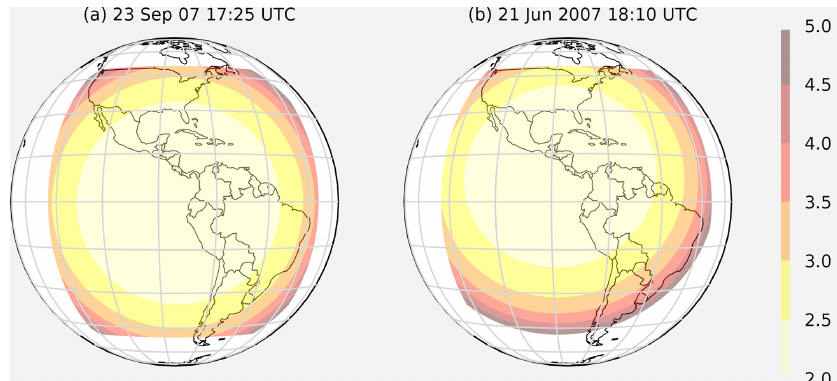
Figure 3. Comparing air mass factors in September (a) and June (b) .